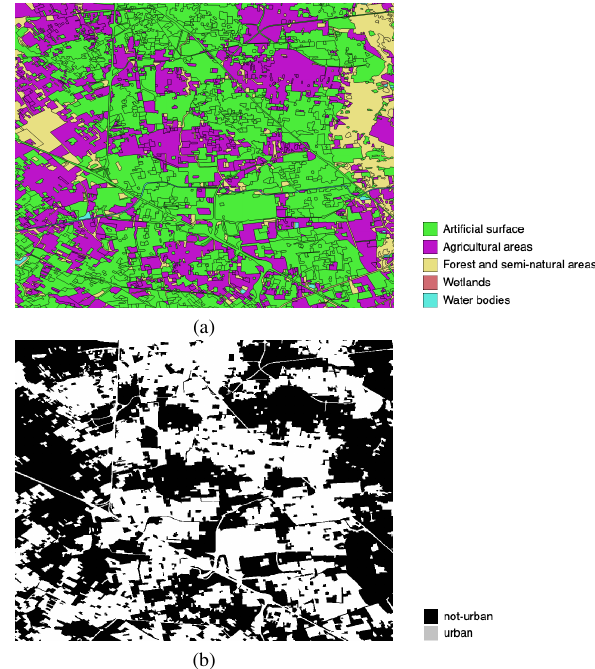
Figure 6: Land cover of Lainate, Italy. (a) DUSAF6 level I label- ing. (b) reclassification into